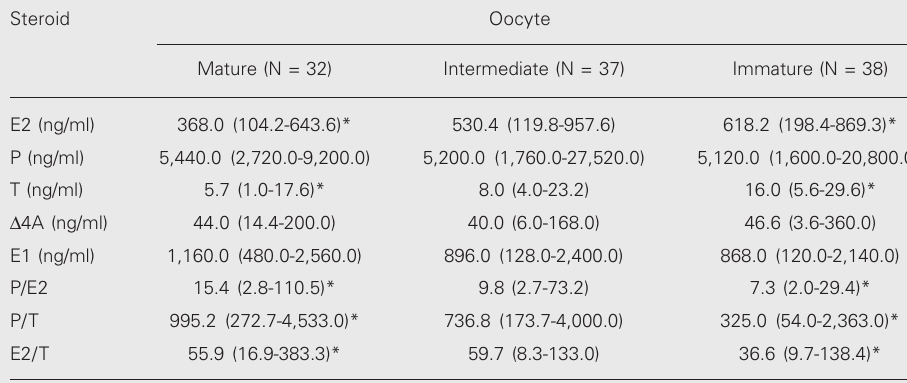
Figure 1. Estradiol (E2), proges- terone (P), and testosterone (T) levels in follicular fluid (FF) and degree of maturity of oocytes retrieved from patients with a cycle hyperstimulated with go- nadotropins E2 (A) and T (B) lev- els were higher in the follicles containing immature oocytes than in the follicles containing mature oocytes (*P < 0.05, Mann-Whitney and Kruskal- Wallis tests). There was no dif- ference in P levels (C) between oocyte groups (P > 0.05, Mann- Whitney